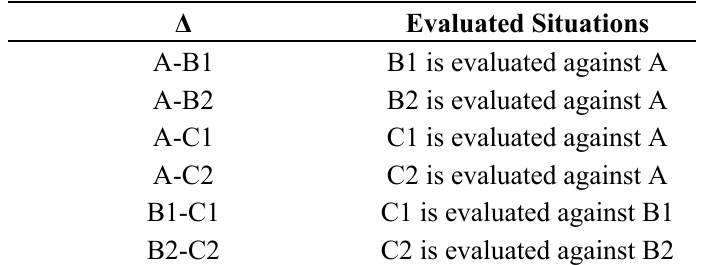
Table 3. Synthesis of the evaluated differences ( Δ ) in the following Figures